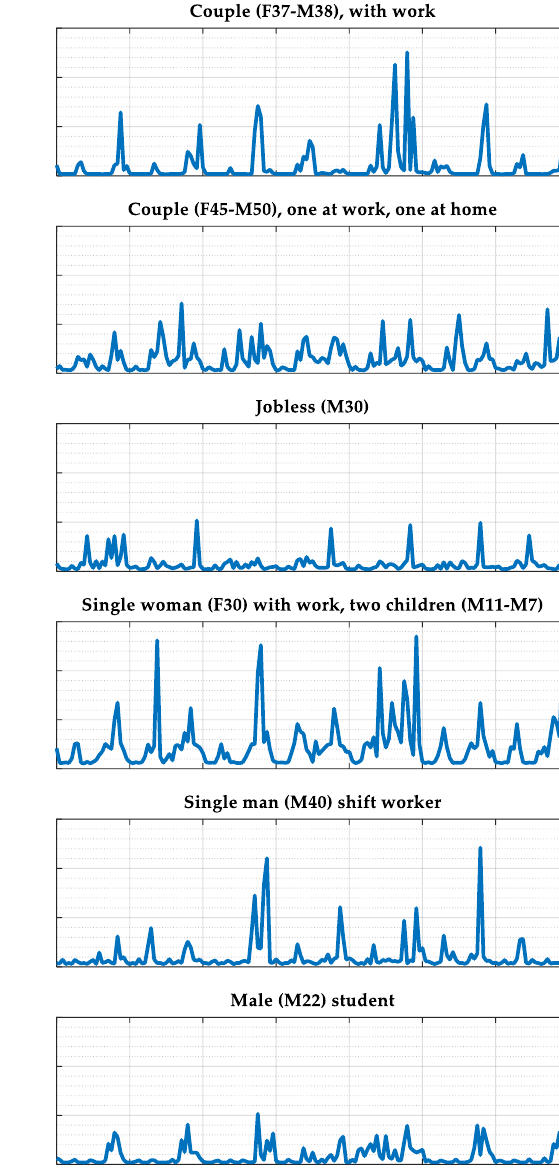
Figure 2. Example of twelve apartment electrical load profiles over the period of one